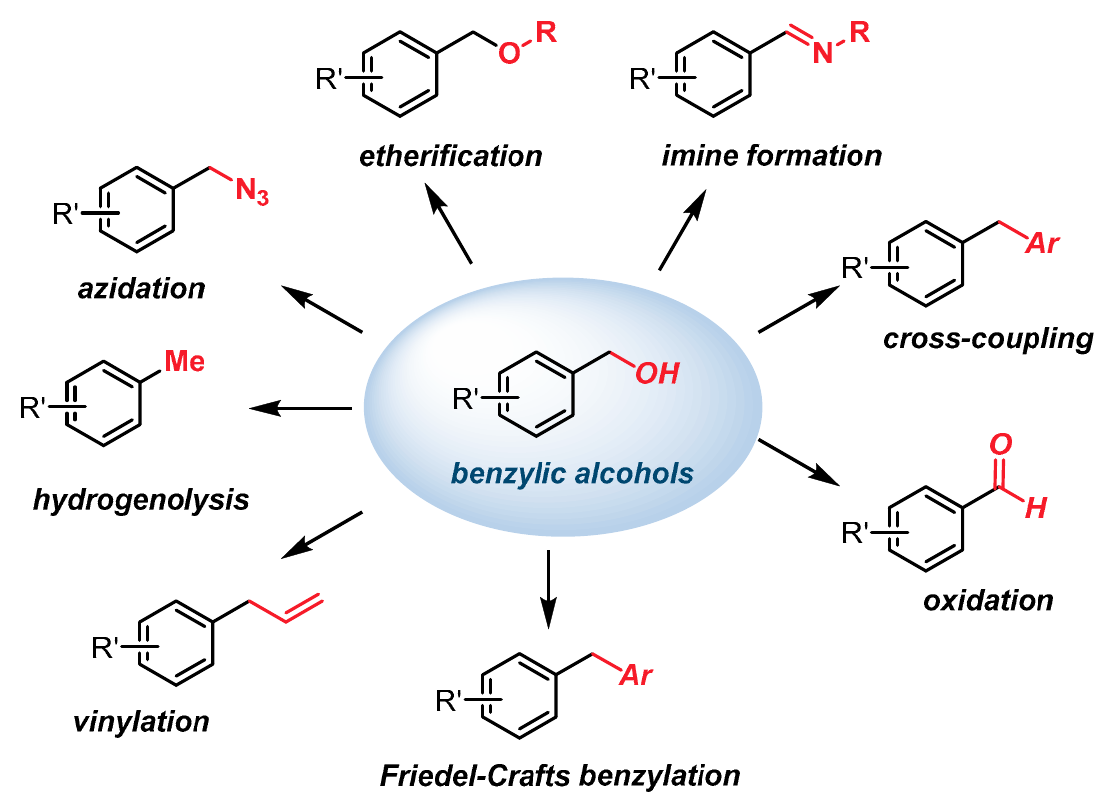
Figure 1. Synthetic applications of benzylic alcohols.